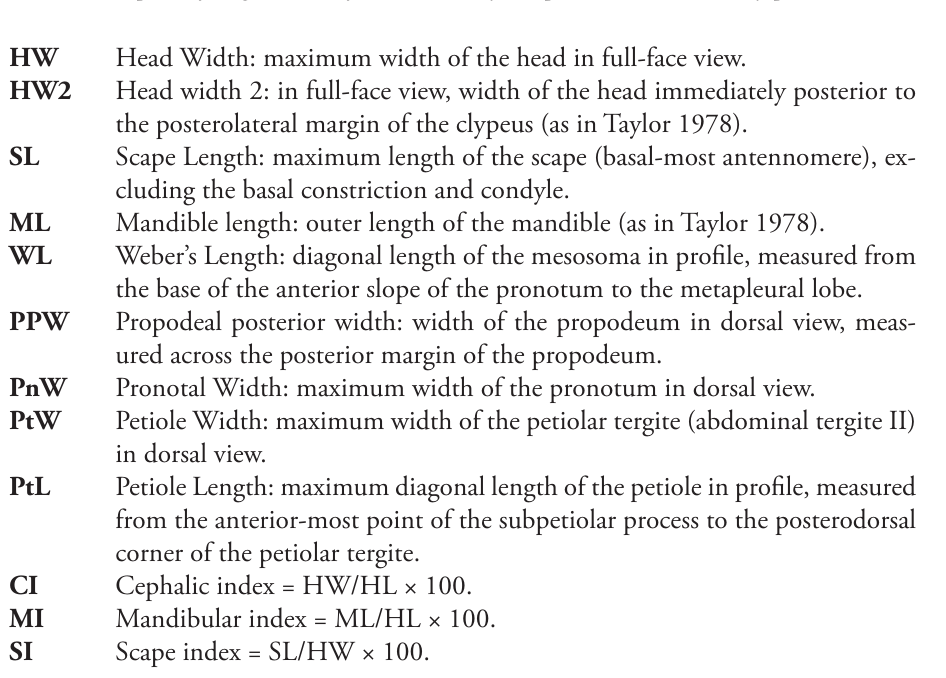
The terminology used follows prior studies: cuticular sculpture (Harris 1979), pilosity inclination (Wilson 1955), morphological terms (Keller 2011), and vestiture (Esteves and Fisher